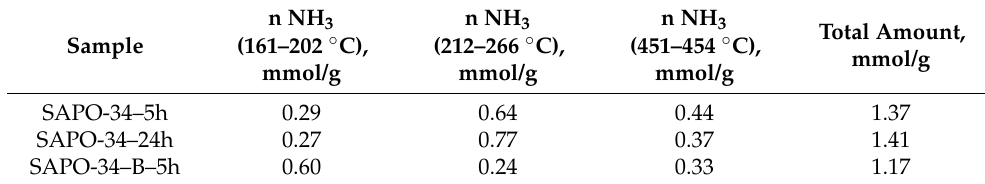
Table 2. Acid properties of SAPO-34.